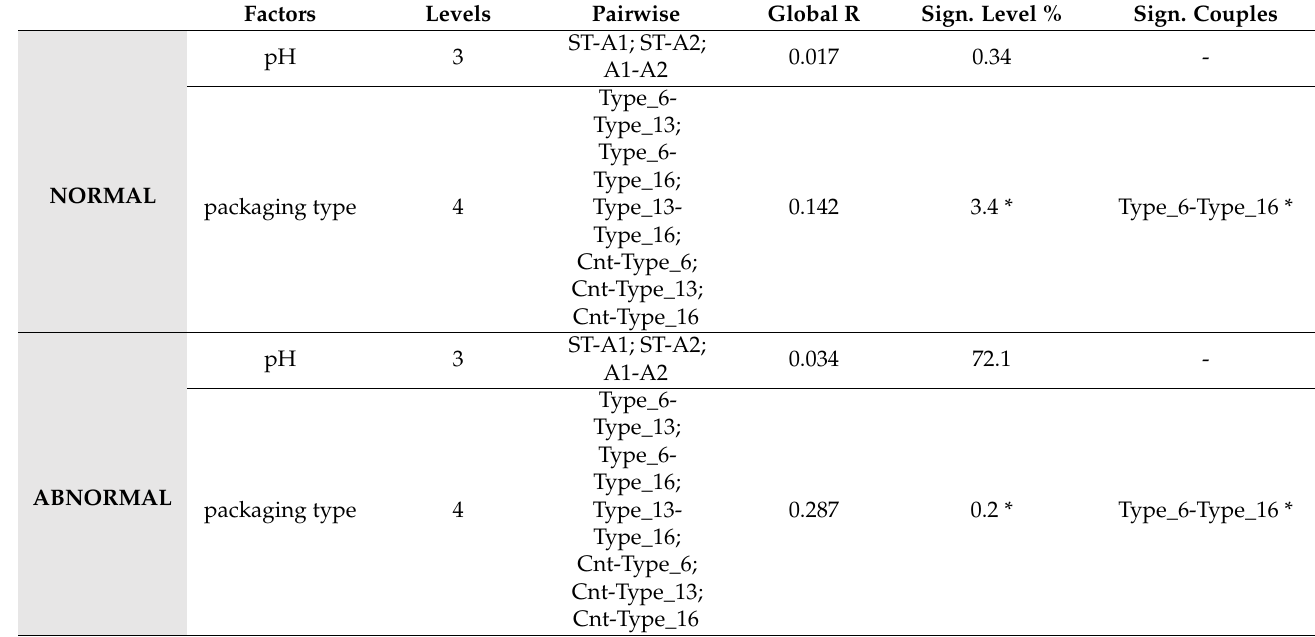
Figure 2. Effect of water acidification in determining abnormal development of P. lividus larvae (100% of dilution). T-test was performed within each plastic type comparing the different scenarios of acidification (ST vs. A1; ST vs. A2; A1 vs. A2). * means weakly significant (0.05 < p -value < 0.01) and ** significant ( p -value < 0.01) compared to both other pH conditions. ST means natural pH. Table 6. ANOSIM test performed on factors affecting biometrics of echinoderms. Notes: Pairwise test performed between couples of considered levels of tested factors is reported (Sign. Couples). Only significant relationships are reported. * = slightly significant. Factors Levels Pairwise Global R Sign. Level % Sign.